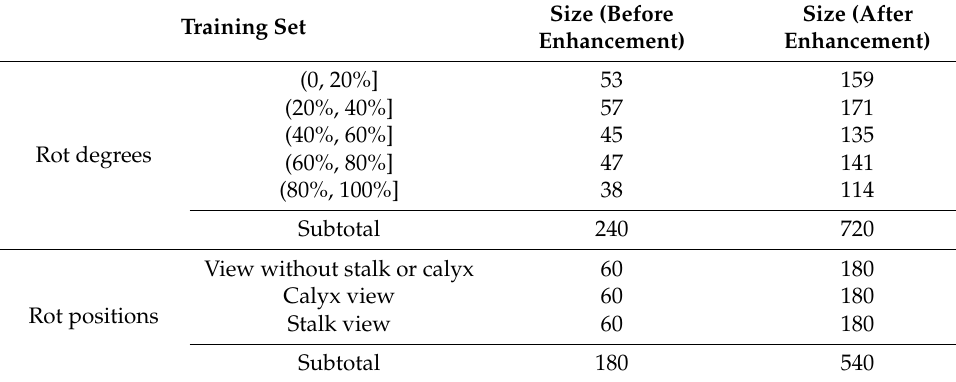
Table 4. Training